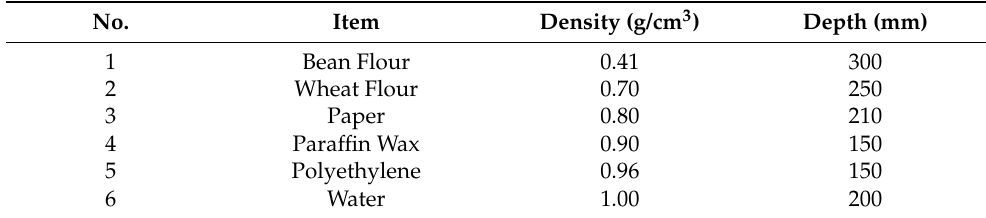
Table 1. Sample material list with density and